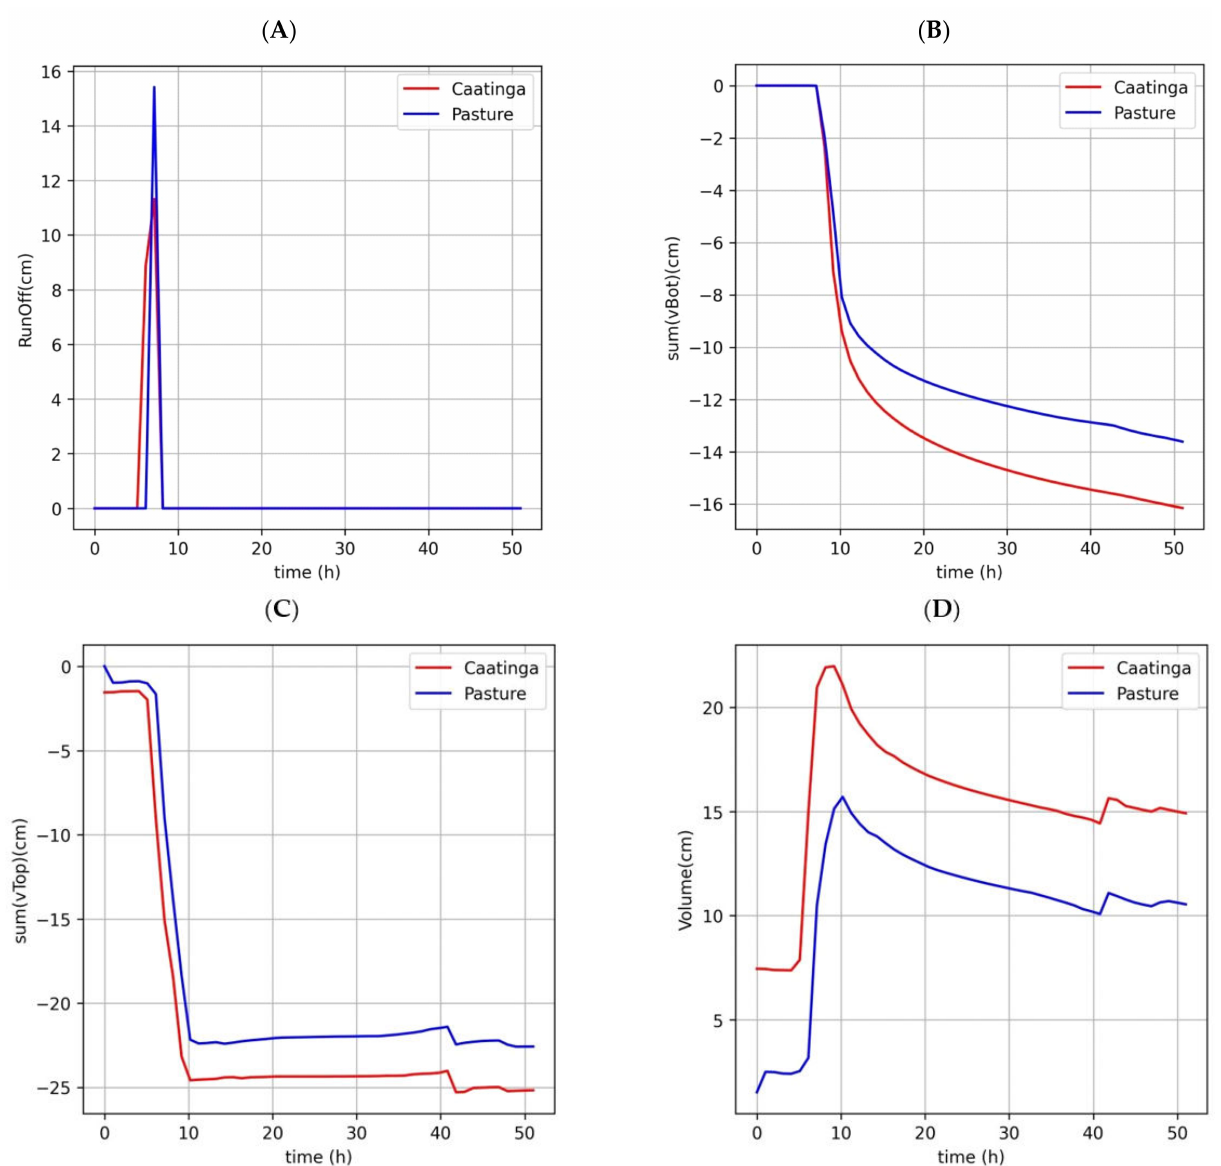
Figure 12. ( A ) Flows of runoff; ( B ) accumulated bottom discharge (sum (vBot)); ( C ) accumulated infiltration (sum (vTop)); ( D ) soil water storage (Volume) of the Caatinga and Pasture